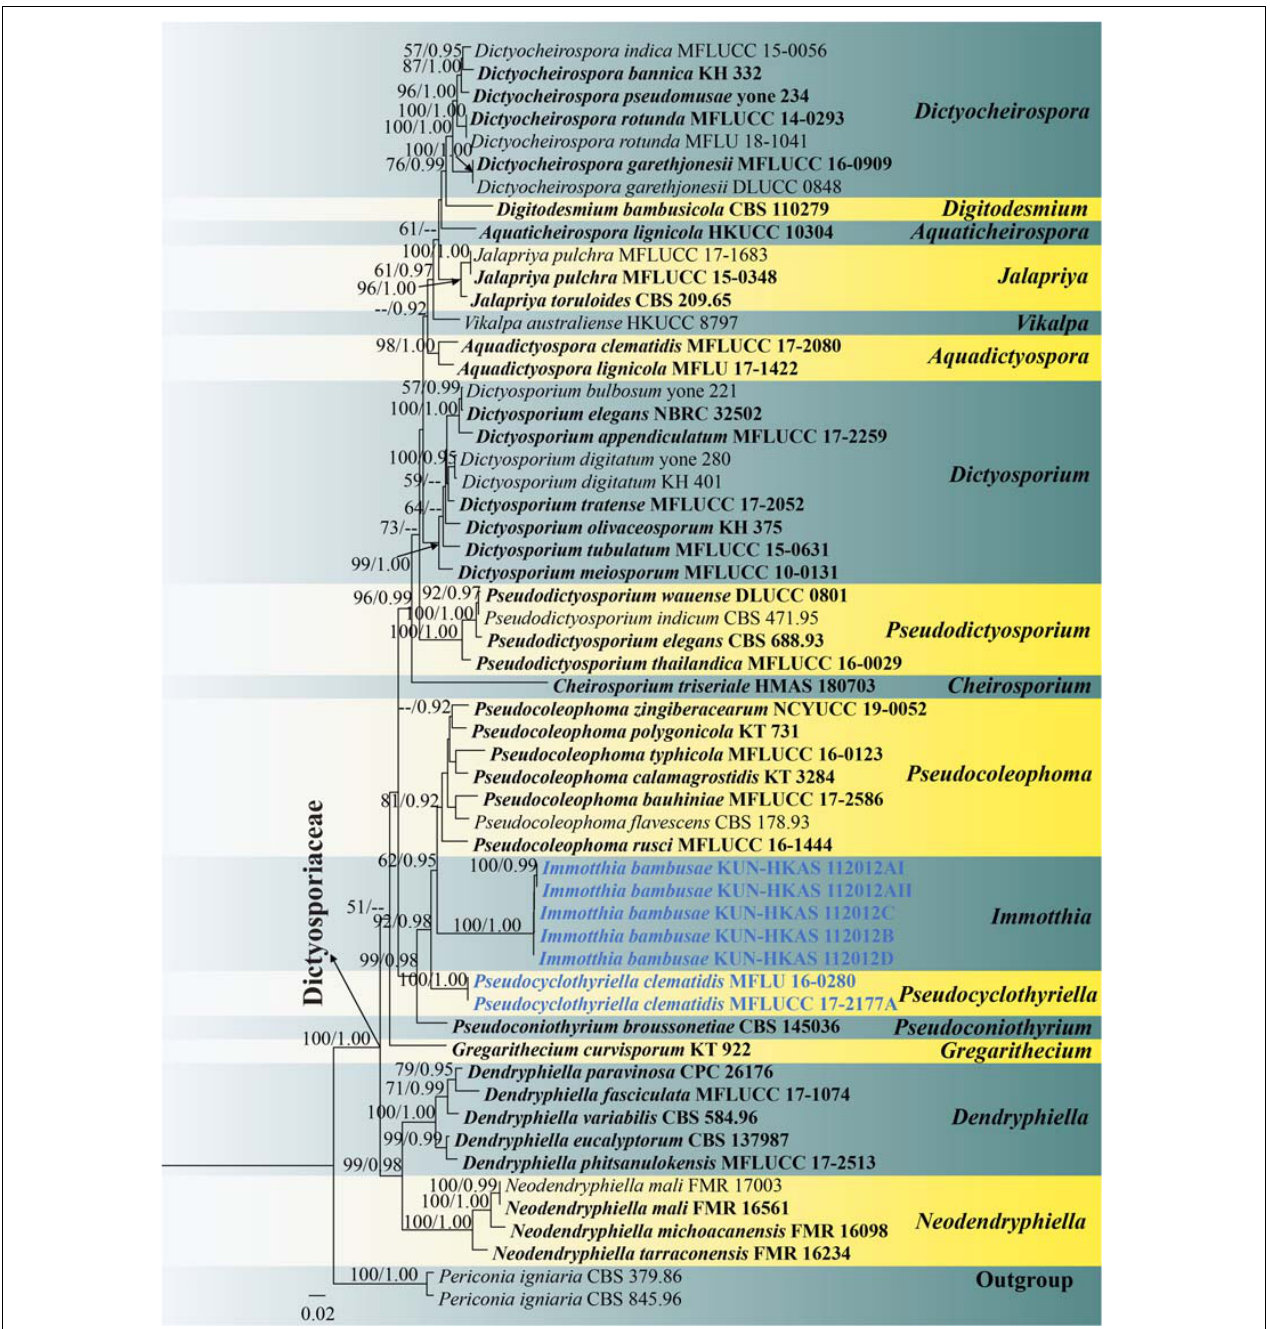
FIGURE 4 | RAxML tree based on a combined ITS, LSU, SSU, and TEF1- α sequence matrix represented the phylogenetic relationships of taxa in Dictyosporiaceae. The tree is rooted to Periconia igniaria (CBS 845.96 and CBS 379.86). Bootstrap support values for ML equal to or greater than 50% and the Bayesian posterior probabilities equal to or higher than 0.90 PP are indicated above the nodes as ML/PP. Ex-type strains are in black bold and the new species and new combinations are indicated in blue